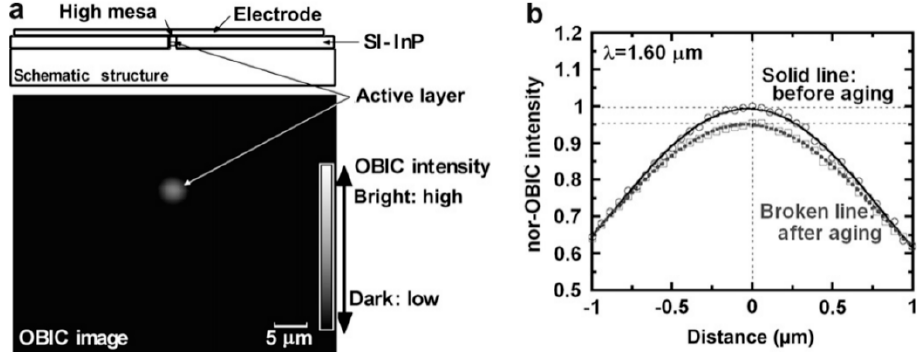
Figure 7. OBIC technique for monitoring the internal degradation of the laser. ( a ) OBIC image of the laser and ( b ) normalized OBIC signal intensity profile. Reprinted with permission from ref. [63] © Elsevier. Copyright 2007 Microelectronics Reliability.